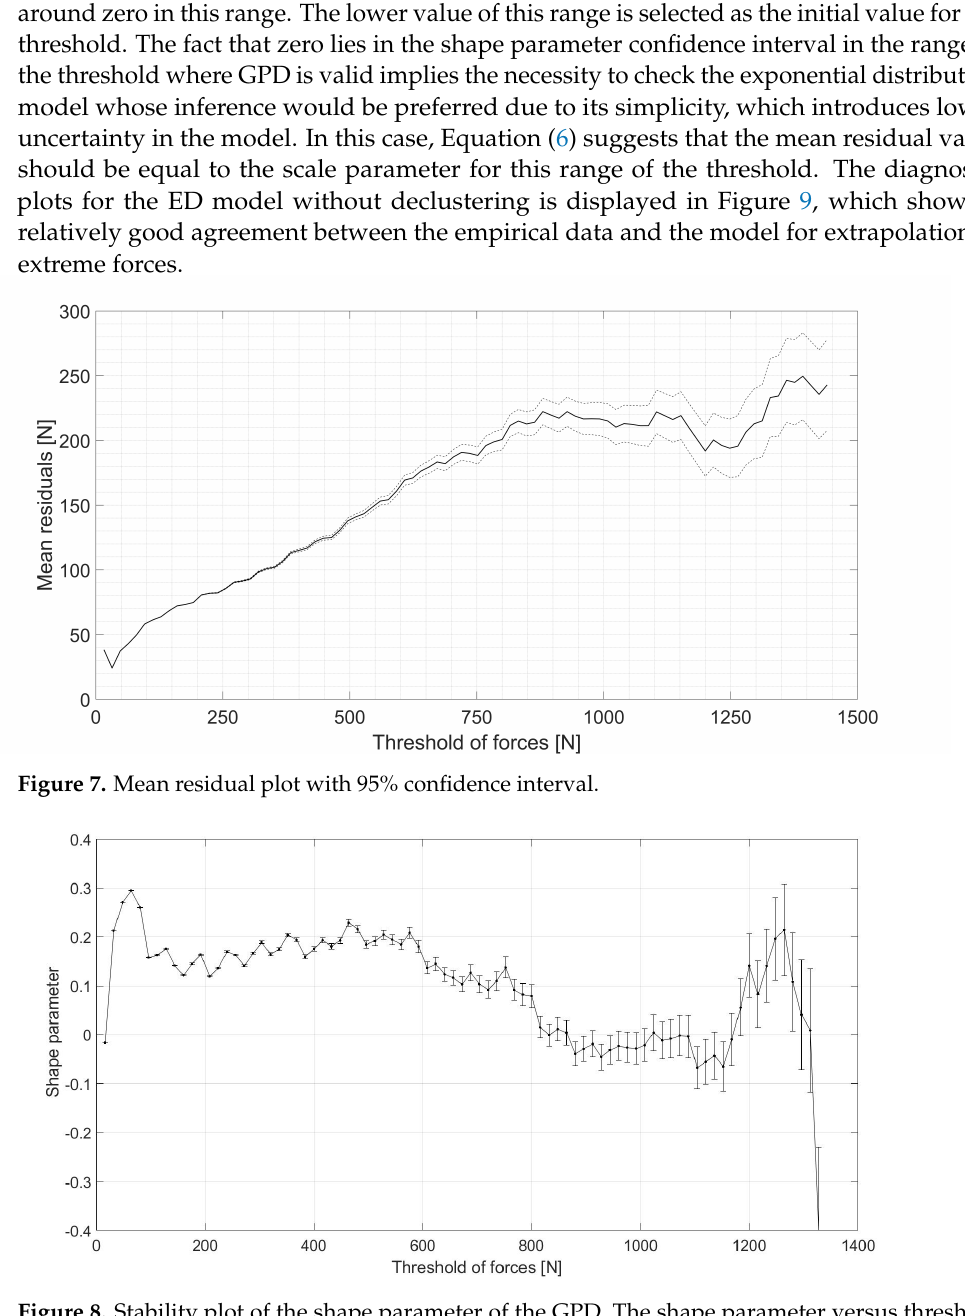
Figure 8. Stability plot of the shape parameter of the GPD. The shape parameter versus threshold together with the 95% confidence interval of the